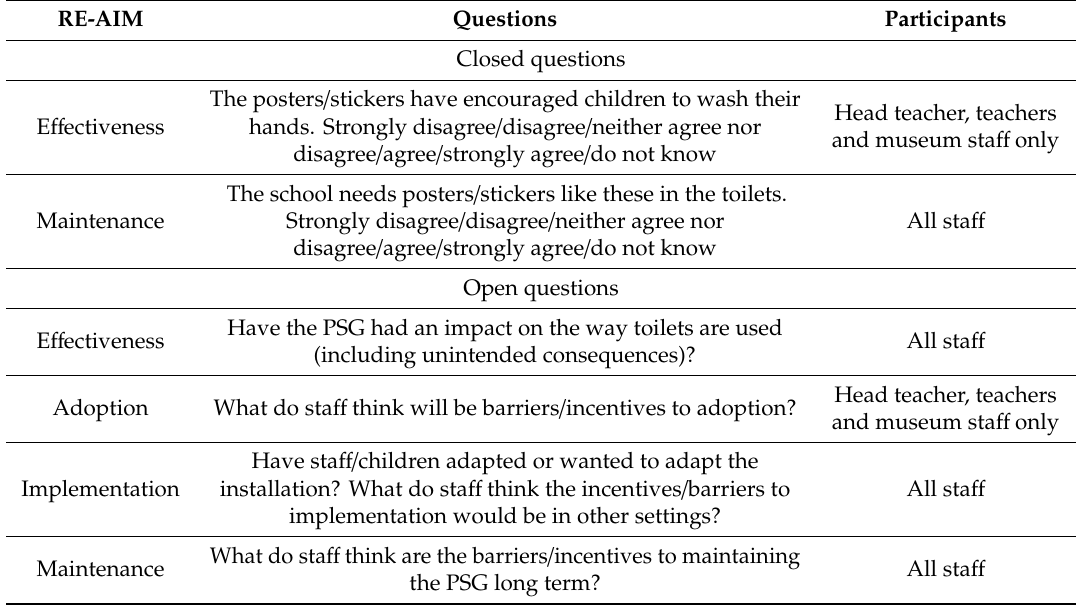
Table 9. Question guide stakeholder